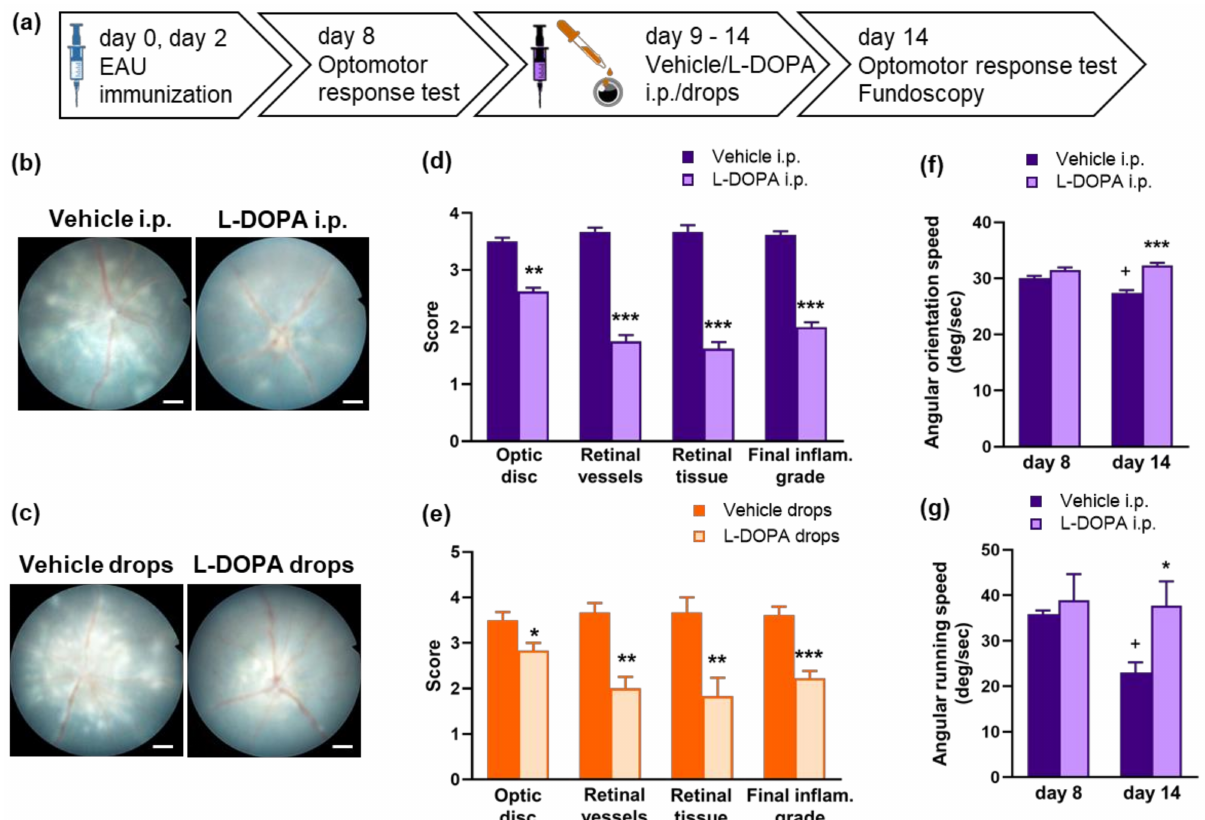
Figure 7. Systemic and topical administration of L-DOPA suppresses the development of severe EAU in Gnat1 rd17 mice. ( a ) Schematic of the experimental design. ( b , c ) Representative fundus images of EAU Gnat1 rd17 mice treated with vehicle or L-DOPA given i.p. or as eye drops. Fundus images were taken on day 14 after immunization. Scale bar: 200 µ m. ( d , e ) EAU clinical score assessed on day 14 after immunization based on retinal inflammation observed in fundus images in vehicle- and L-DOPA-treated EAU Gnat1 rd17 mice. The data shown are the mean ± SEM of 6–8 eyes from 6–8 mice per group and are representative of two experiments. * p < 0.05, ** p < 0.01, and *** p < 0.001: significant differences by unpaired t -test for comparisons between groups with i.p. injection of vehicle, and L-DOPA and paired t -test for comparisons between groups of vehicle-treated contralateral eyes and L-DOPA-treated ipsilateral eyes in the same animals. Optomotor responses: ( f ) angular orientation speed and ( g ) angular running speed in EAU Gnat1 rd17 mice that were treated with vehicle or L-DOPA i.p. injection, measured in the optomotor drum on days 8 and 14 after immunization. Data shown are the mean ± SEM of 4 mice in each group; one representative out of two experiments is shown. * p < 0.05 and *** p < 0.001 by unpaired t -test for comparison between vehicle- and L-DOPA-treated EAU Gnat1 rd17 groups; + p < 0.05 by paired t -test for comparison between days 8 and 14 within the same